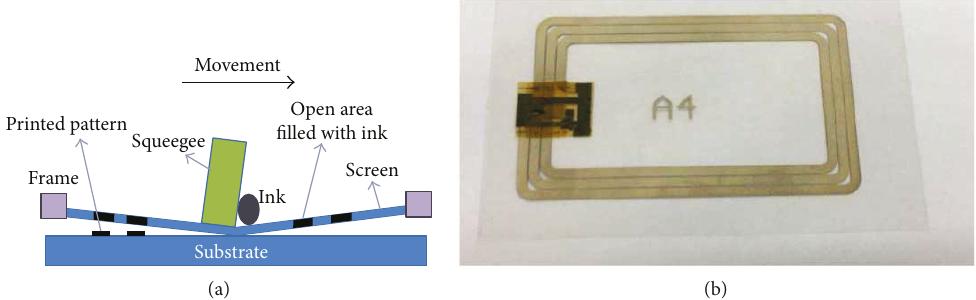
Figure 7: (a) Screen printing process [6]. (b) Screen-printed fl exible antenna